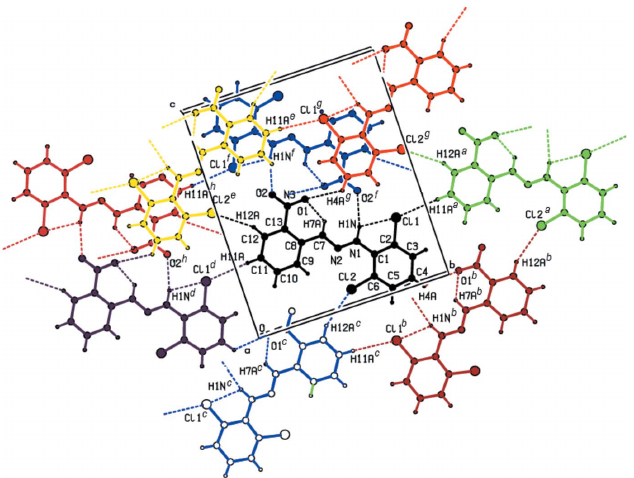
Figure 4 A general view of the crystal packing along the a axis of the title compound. Dashed lines indicate the intramolecular N—H (cid:3)(cid:3)(cid:3) Cl, C— H (cid:3)(cid:3)(cid:3) O, intermolecular N—H (cid:3)(cid:3)(cid:3) O, C—H (cid:3)(cid:3)(cid:3) Cl interactions and Cl (cid:3)(cid:3)(cid:3) H, O (cid:3)(cid:3)(cid:3) H contacts. [Symmetry codes: ( a ) x , 1 + y , z ; ( b ) (cid:4) 1 ( c ) (cid:4)